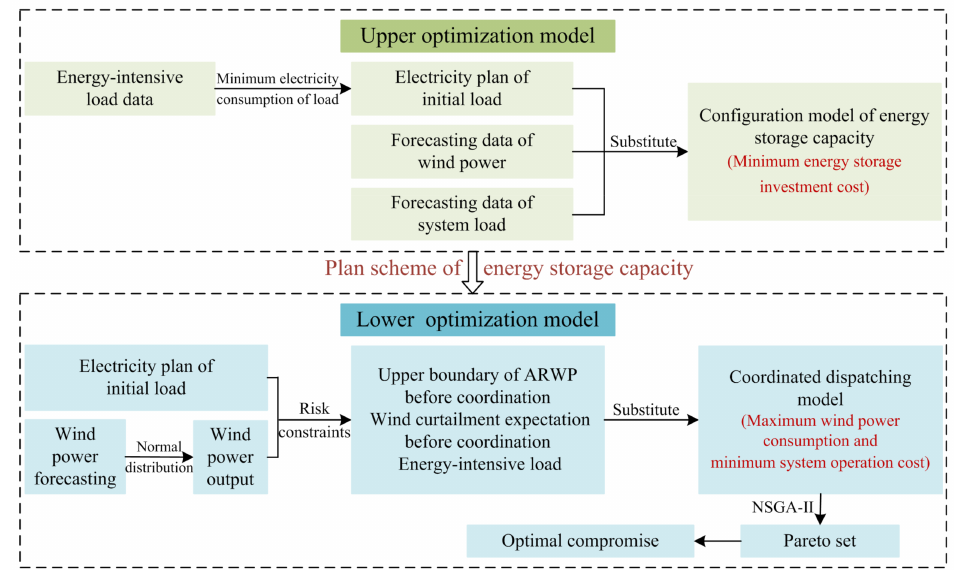
Figure 7. Flowchart of bi-level optimization model considering congested wind power